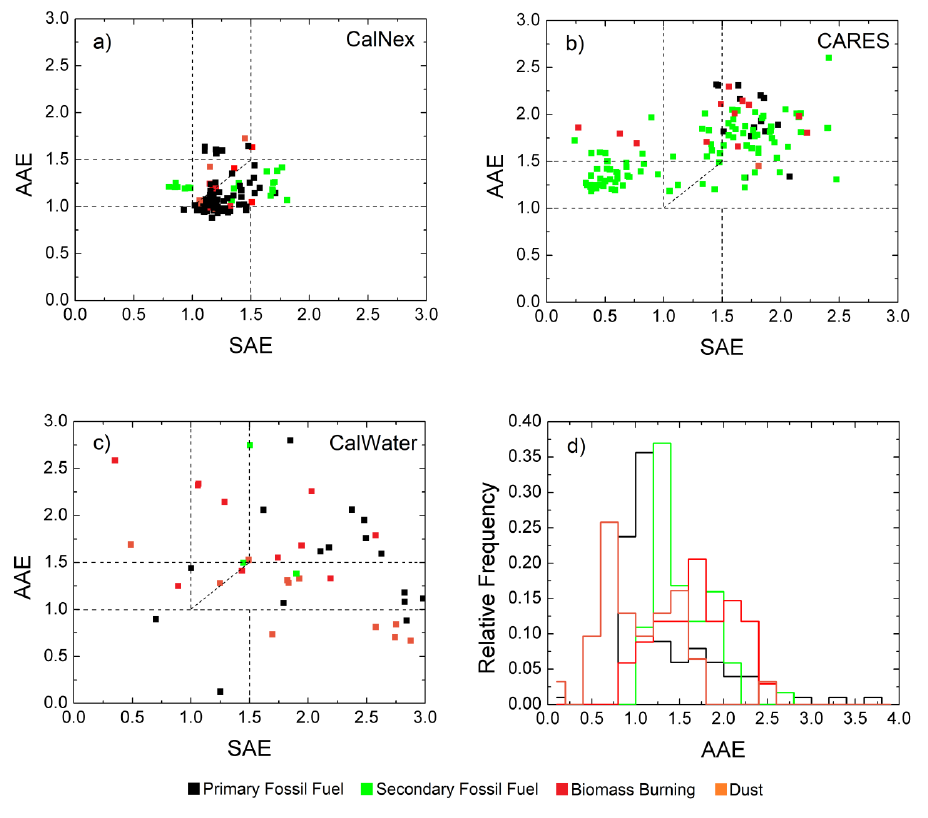
Fig. 6. Absorption Ångström Exponent vs. Scattering Ångström Exponent scatter plot of in-situ aircraft measurements for (a) CalNex, (b) CARES, and (c) CalWater where the color code represents the dominant aerosol source detected with the A-ATOFMS for each measurement. Panel (d) is a frequency histogram of the Absorption Ångström Exponent for each aerosol source.